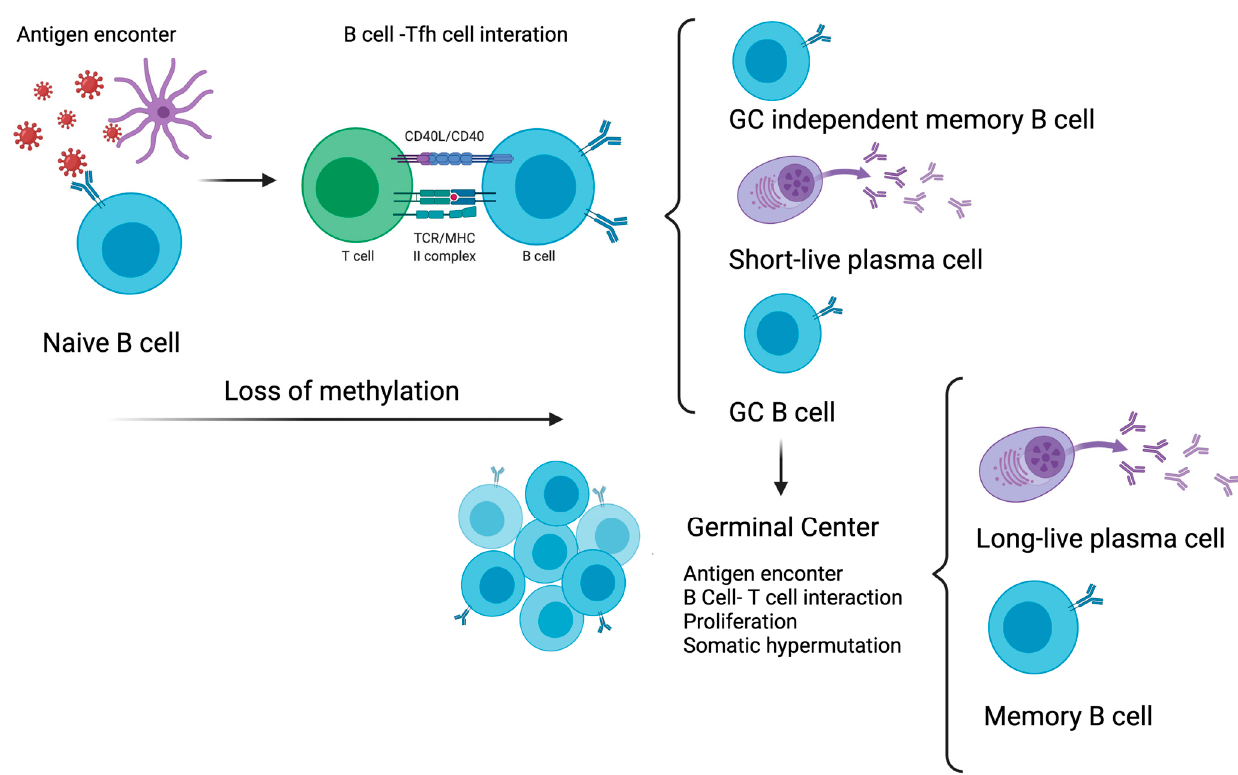
Figure 3. DNA methylation and memory B cell: A—differentiation of naïve B cells into short-lived plasma cells and germinal centre (GC) B cells. B—differentiation of GC B cells into long-lived plasma cells and secondary memory B cells. This process occurs in lymphoid organs in the B cell follicles and the germinal centres. The transition from naïve to GC B cell is dominated by loss of methylation in immune activation-induced DNA methylation regions.